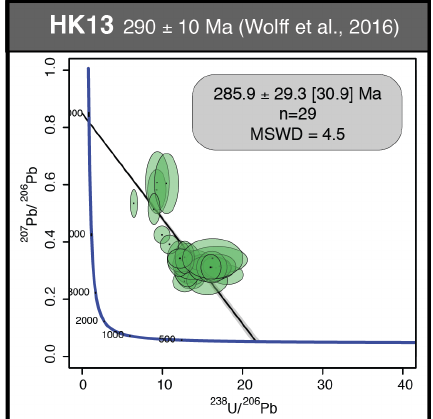
Figure A3. Tera–Wasserburg diagrams of secondary fluorite ref- erence materials; HK13 fluorite dated at 290 ± 10Ma by Wolff et al.